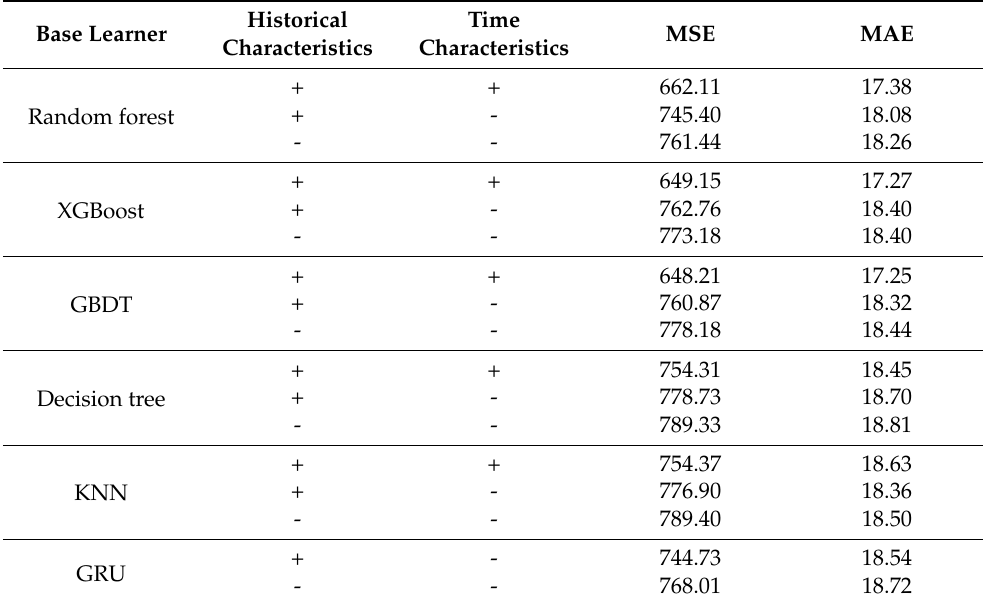
Table 1. A comparative analysis of the prediction effects of different characteristics. Base